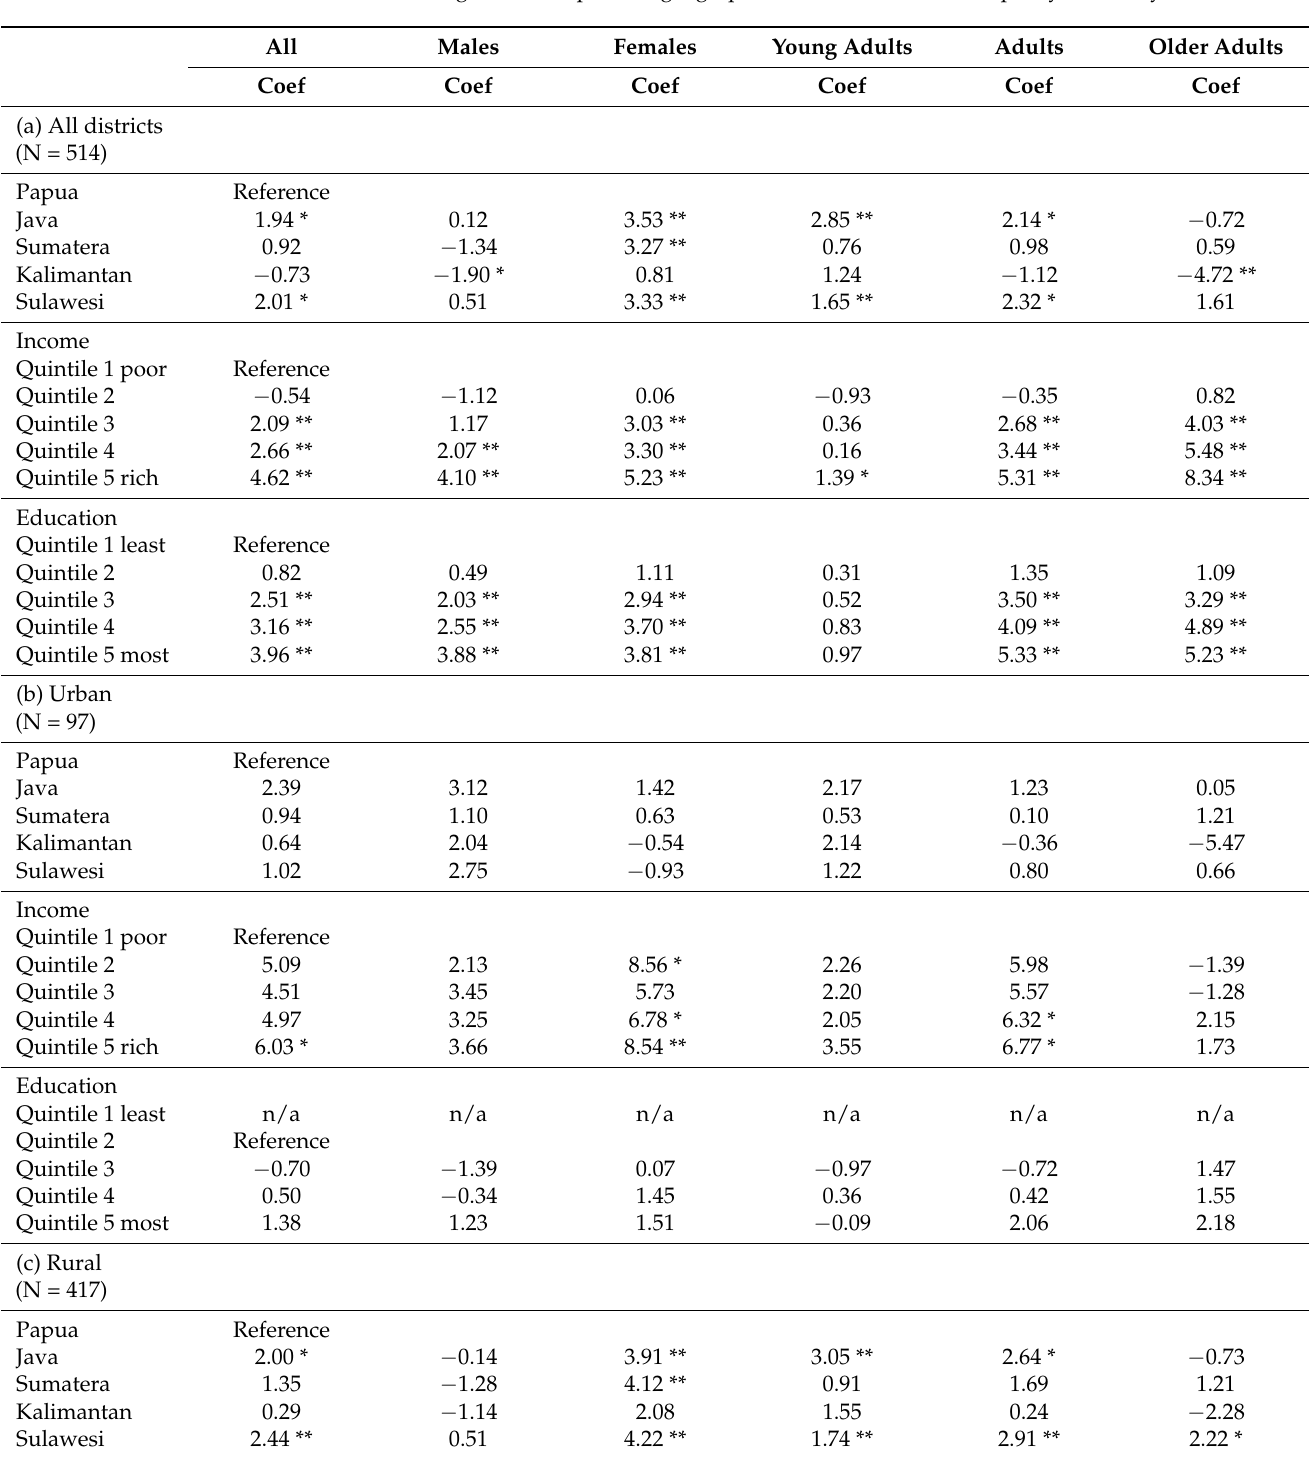
Table A2. Regression outputs for geographic and socioeconomic disparity in